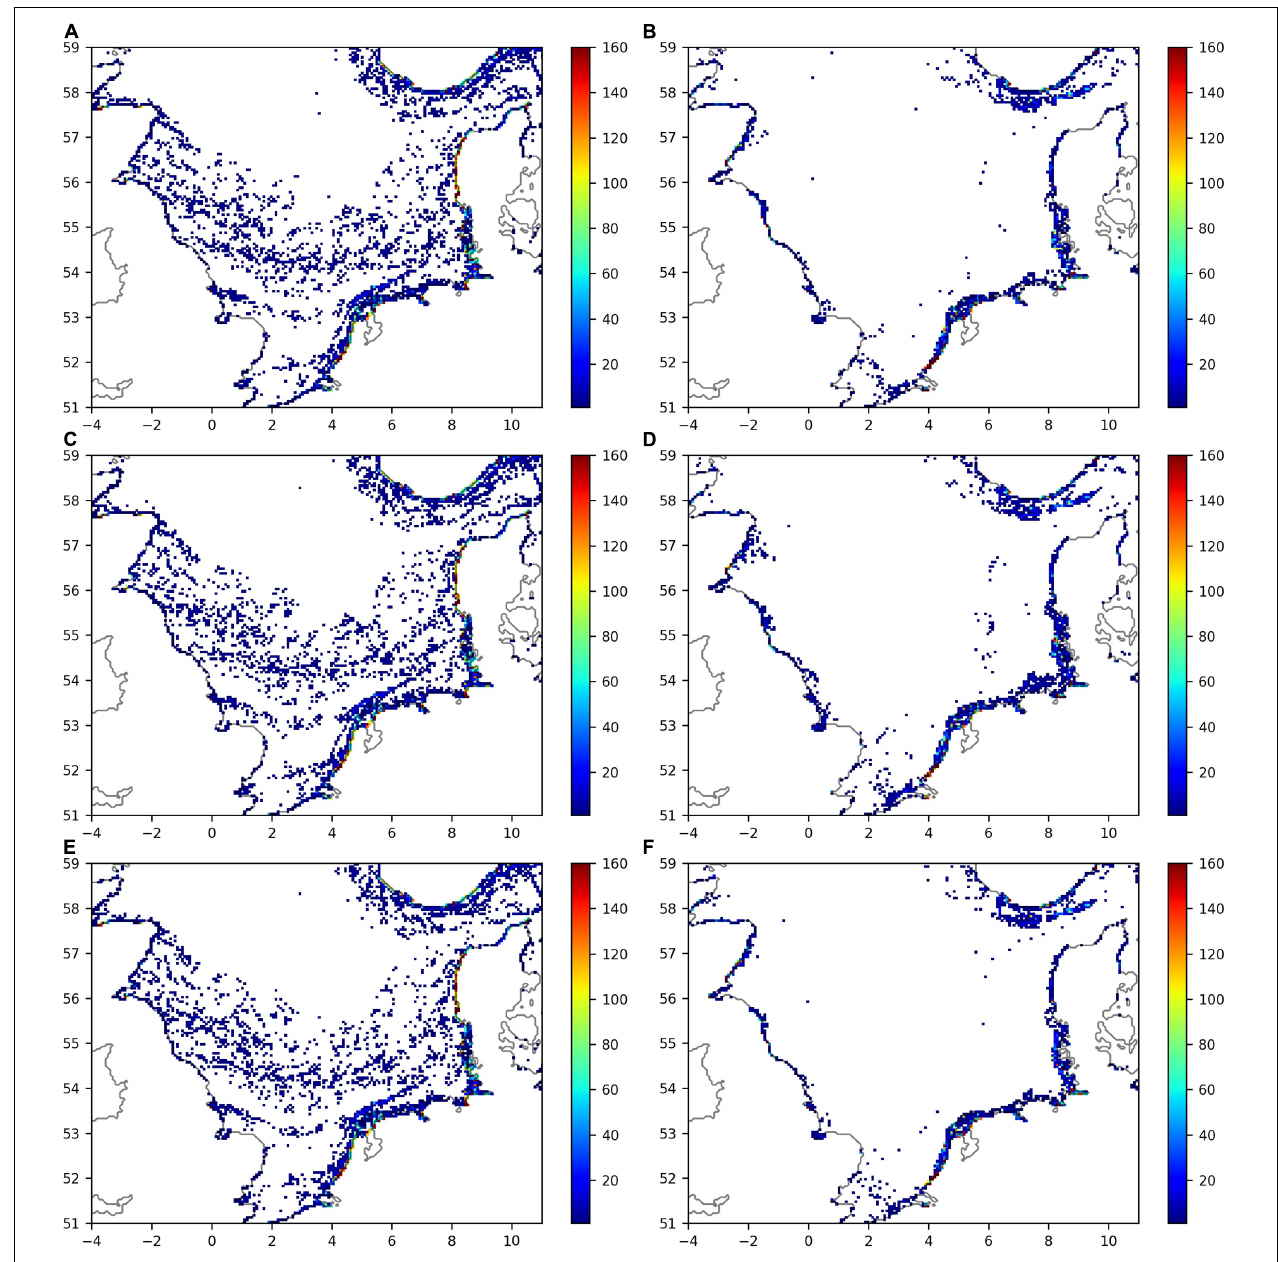
FIGURE 4 | Particle densities (number of particles per grid cell) for the proportional release experiment. (A) Density on 30 December 2017 for floating particles (0.06 ms − 1 ), (B) density on 30 December 2017 for sinking particles ( − 0.004 ms − 1 ), (C) floating particles (0.05 ms − 1 ), (D) sinking particles ( − 0.0015 ms − 1 ), (E) floating particles (0.07 ms − 1 ), (F) sinking particles ( − 0.006 ms − 1 ). Coordinates are latitude and longitude in